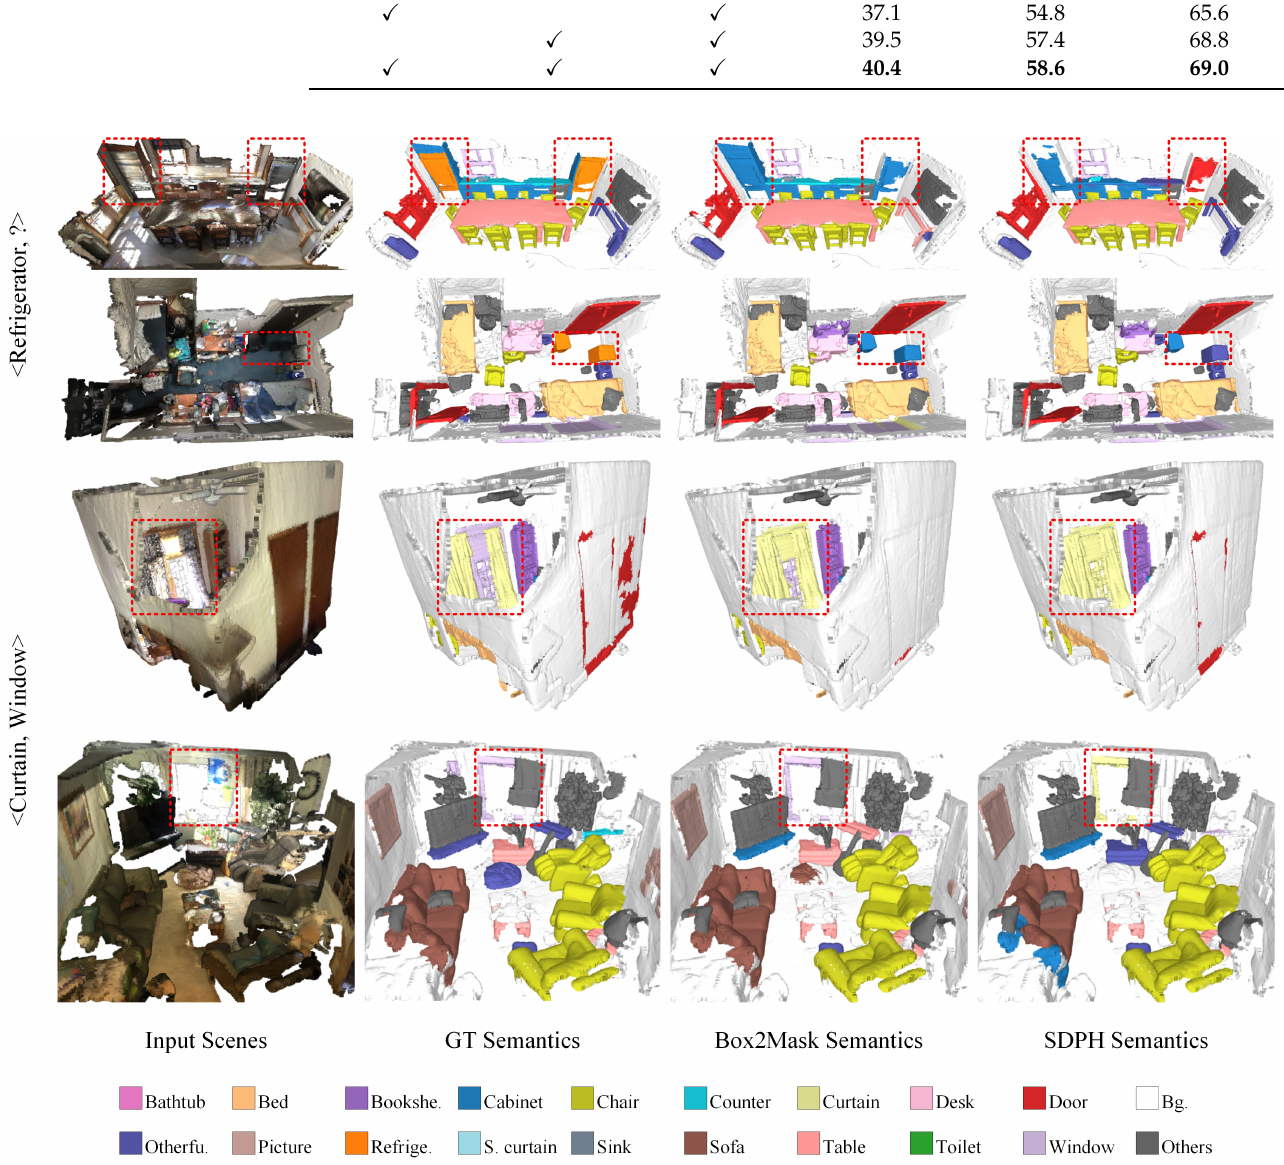
Figure 9. Bad cases on ScanNet-v2 in the noise-free setting. The first two rows show that refrigerators could be misclassified as cabinets, doors, and other furniture. We use “?” to represent this complicated situation. The last two rows show that windows could be misclassified as curtains, which lowered both categories’ performance. The legend is employed to distinguish among different semantic meanings, and the key differences are marked out with red dashed